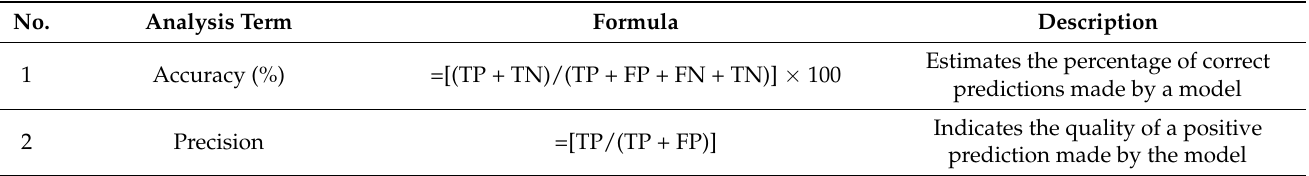
Table 2. Common techniques to measure the performance of artificial intelligent models during image